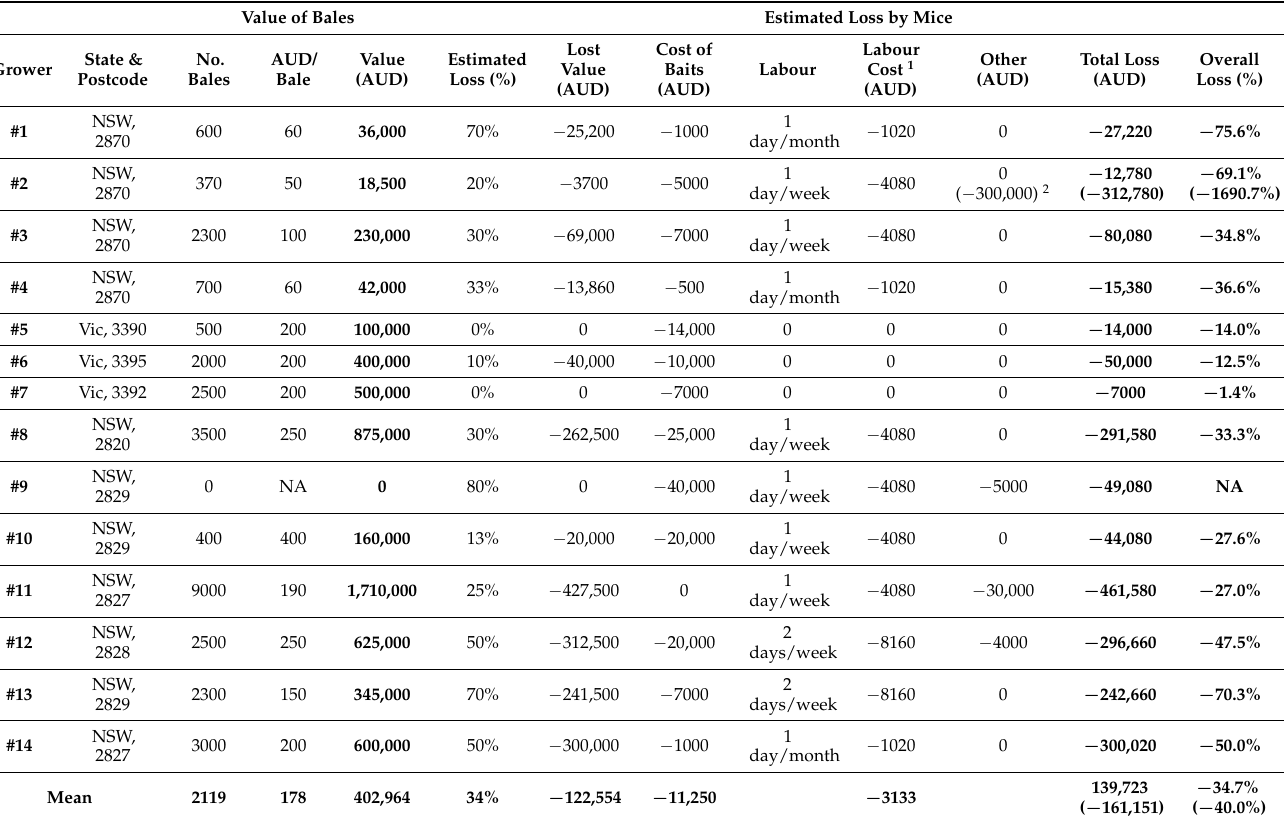
Table 2. Grower-reported estimates of the economic cost of managing mice in fodder storage sysTable 14. The value of bales is calculated (number of bales × value/bale), then the estimated loss by mice and the cost of control efforts (including labour) are subtracted to derive a total loss. Overall loss (%) was calculated by as a ratio of total loss/total value. Costs and losses are negative values (“ −